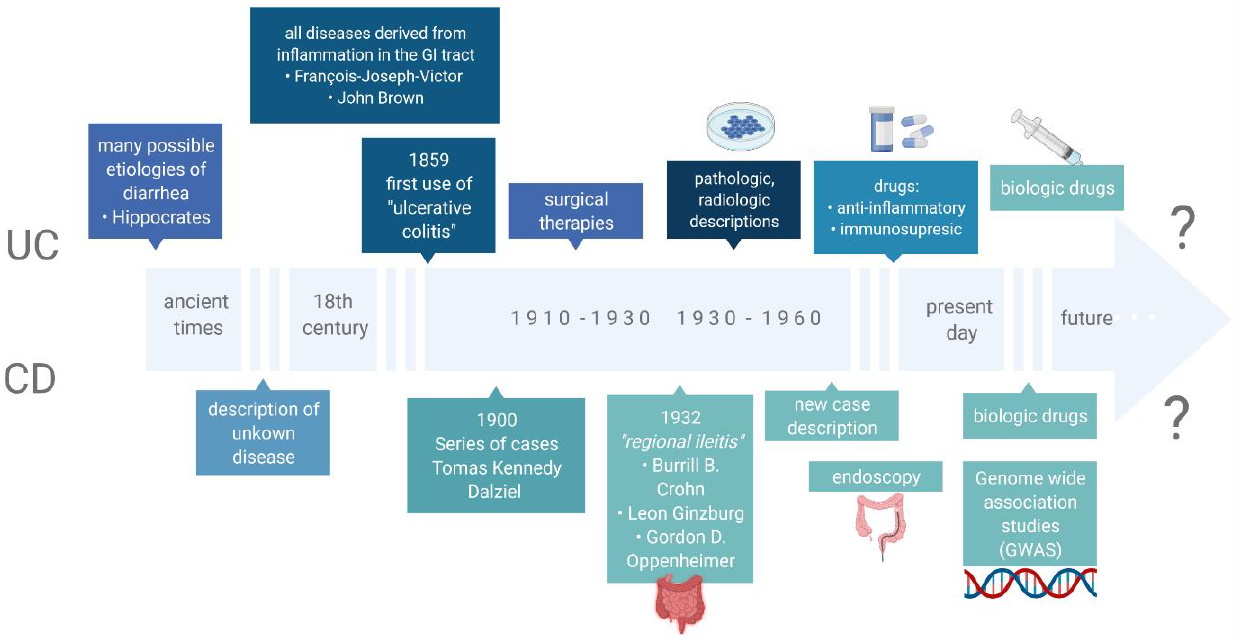
Figure 1. The most relevant findings related to IBD.